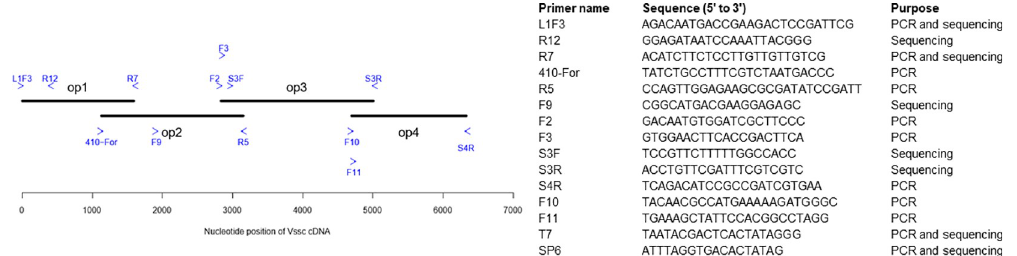
Fig 2. The Vssc cDNA from the ROCK and LKR strains was obtained by PCR and cloning of four overlapping fragments. The overlapping pieces and relative position of primers (blue arrows) are shown in the diagram. List of the primers, sequences and purposes are also